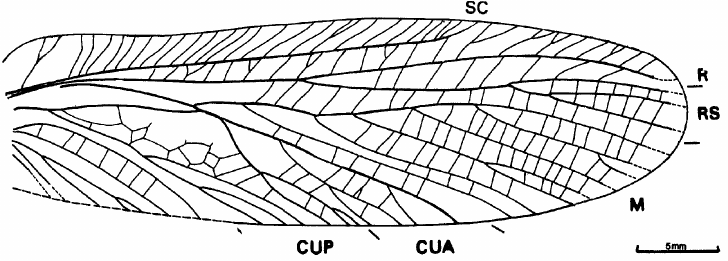
Fig. 24. Nacekomia rossae, drawing of fore wing based on holotype no. FMNH PE